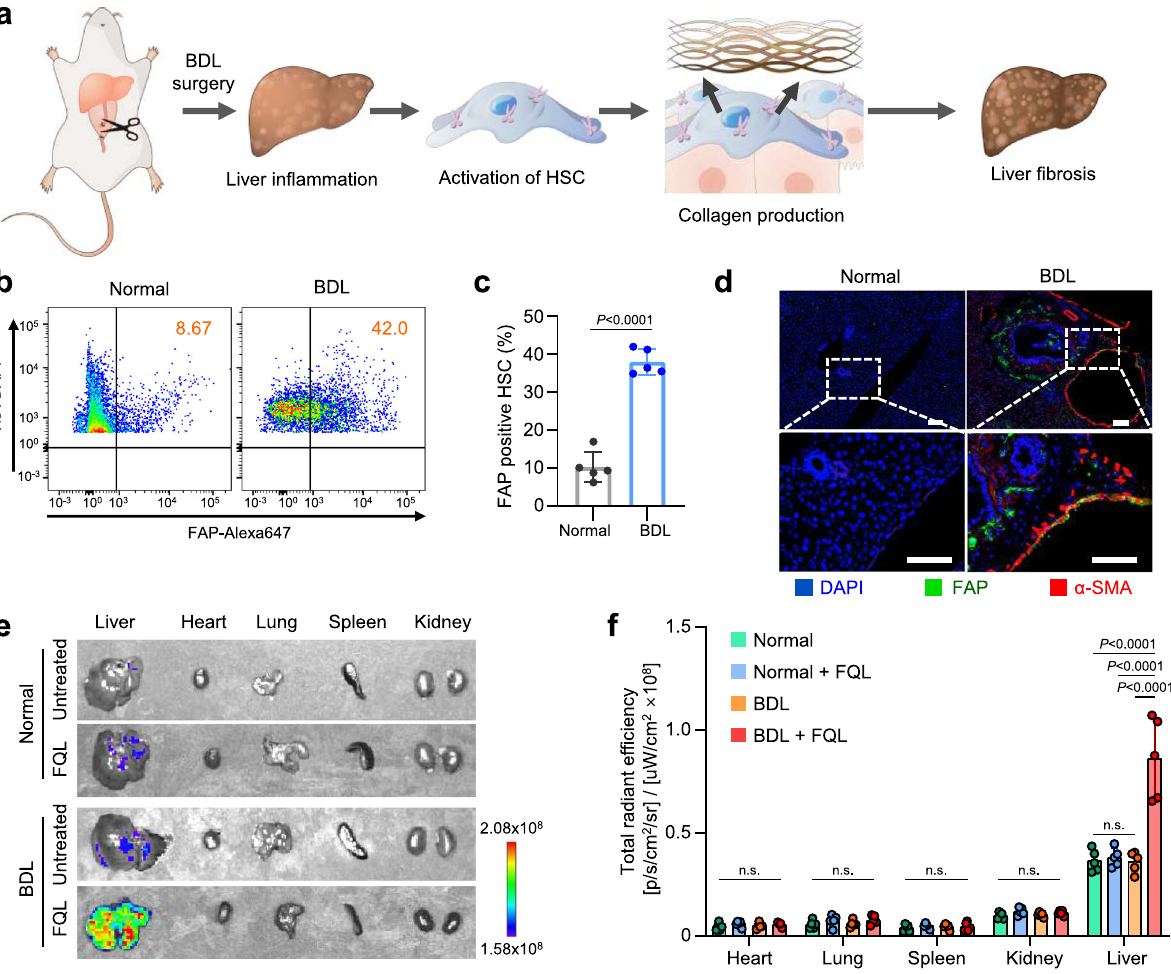
Fig. 4 FAP-mediated cleavage of liposomal promelittin in BDL induced fi brosis mice. a Experimental scheme for induction of liver fi brosis using the BDL method ( n = 5 biologically independent mice per group). b , c FAP expression level in HSC from normal mice or BDL mice was analyzed by fl ow cytometry. ( n = 5 biologically independent samples per group). Signi fi cant differences were assessed using a one-way ANOVA with Tukey test (Tukey ’ s test P BDL - Normal < 0.0001). Results are presented as mean ± S.D. d Immunohistochemical staining for FAP in liver tissues from normal and BDL mice (